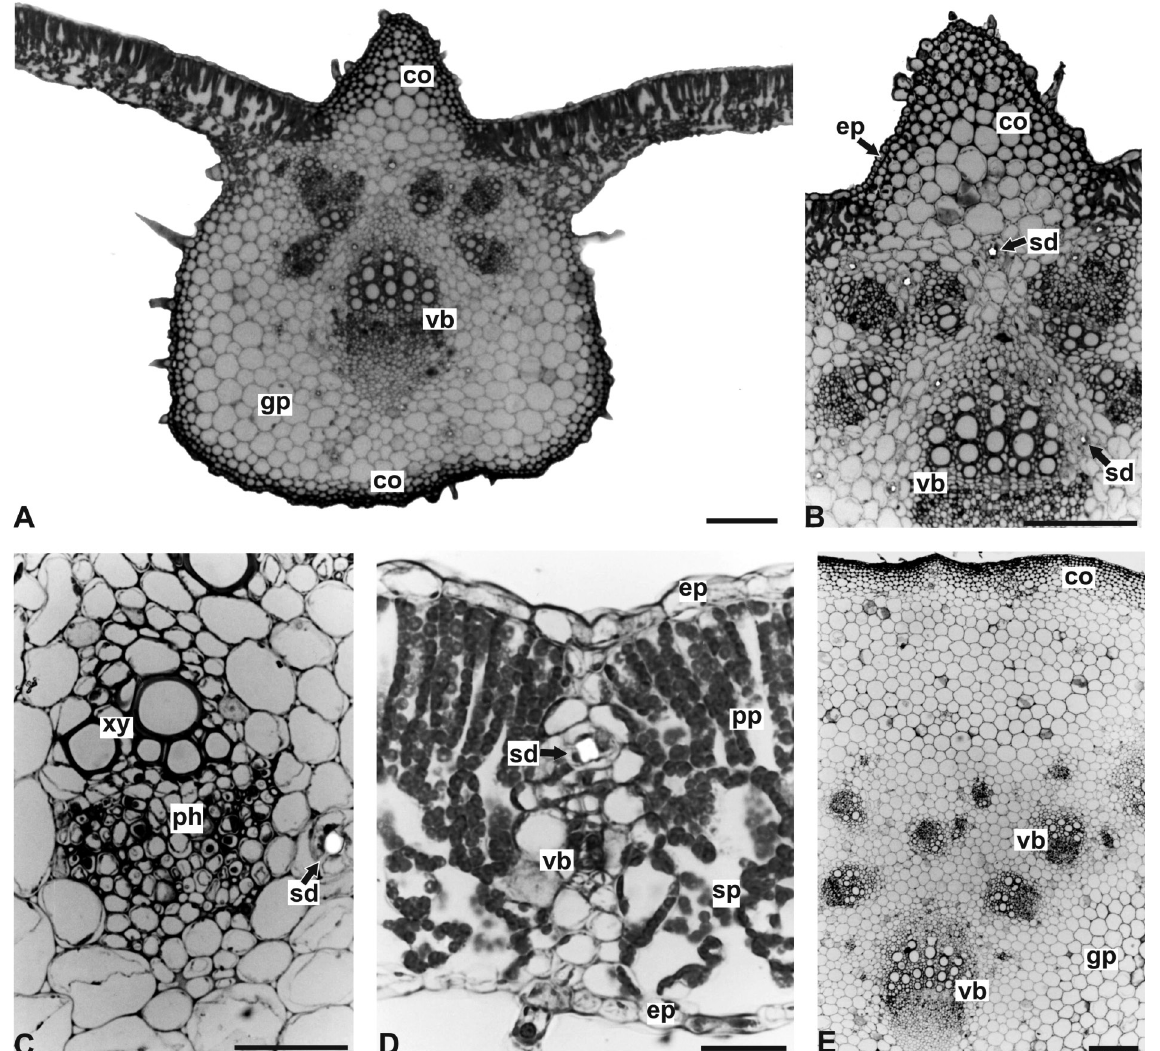
FIGURE 3 - A-E : Tithonia diversifolia (Hemsl.) A. Gray – leaf in transverse section: A . Intervein region and midrib with biconvex contour; B . Epidermis, collenchyma and vascular bundles in the midrib; C . Detail of a collateral vascular bundle and a secretory duct; D . Intervein region, displaying dorsiventral mesophyll and minor vascular bundle; E . Petiole. Abbreviations: co –